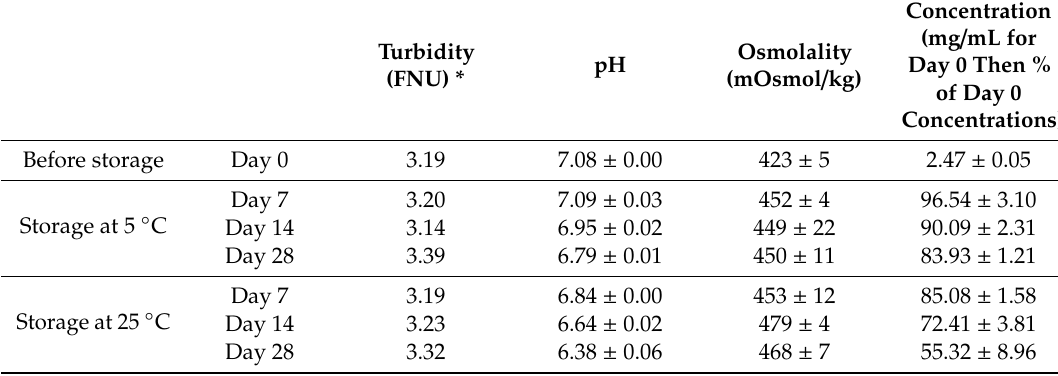
Table 3. Evolution of studied parameters for the amphotericin B 2-hydroxypropyl- γ -cyclodextrin formulation added with 0.5 mg / mL of ascorbic acid. n = 4; mean ± standard deviation, except for *: n = 1. FNU: Formazin Nephelometric